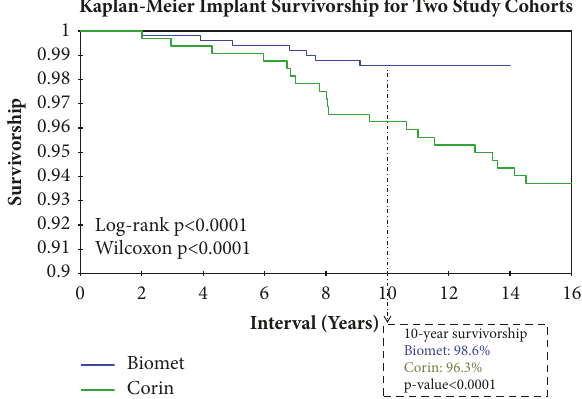
Figure 2: Kaplan-Meierimplant survivorshipfor two study cohorts. Kaplan-Meier implant survivorship analysis using late acetabular failure as an endpoint. All cases in both groups have a minimum of 10 years’ follow-up. At 10 years, survivorship is 97.2% for Biomet and 96.0% for Corin (p=0.0008). Late acetabular failure is defined as failure of acetabular component > 2 years. Results of the log-rank test (p value < 0.0001) and Wilcoxon test (p value < 0.0001) show significant difference in the occurrence of late acetabular failures between the two implant groups.